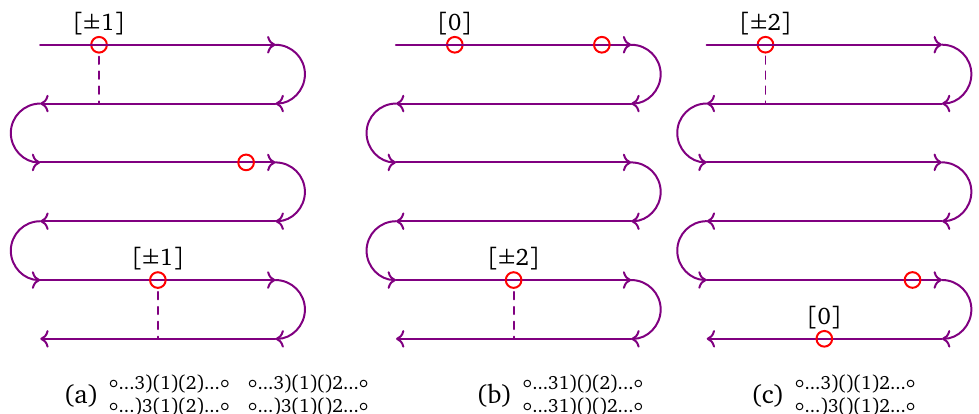
Figure 9: Same three operators in Fig. 7, but now in wing configurations of spread 2. The dashed lines denote the possible positions of operators. There are 4 + 2 + 2 = 8 wing configurations of spread